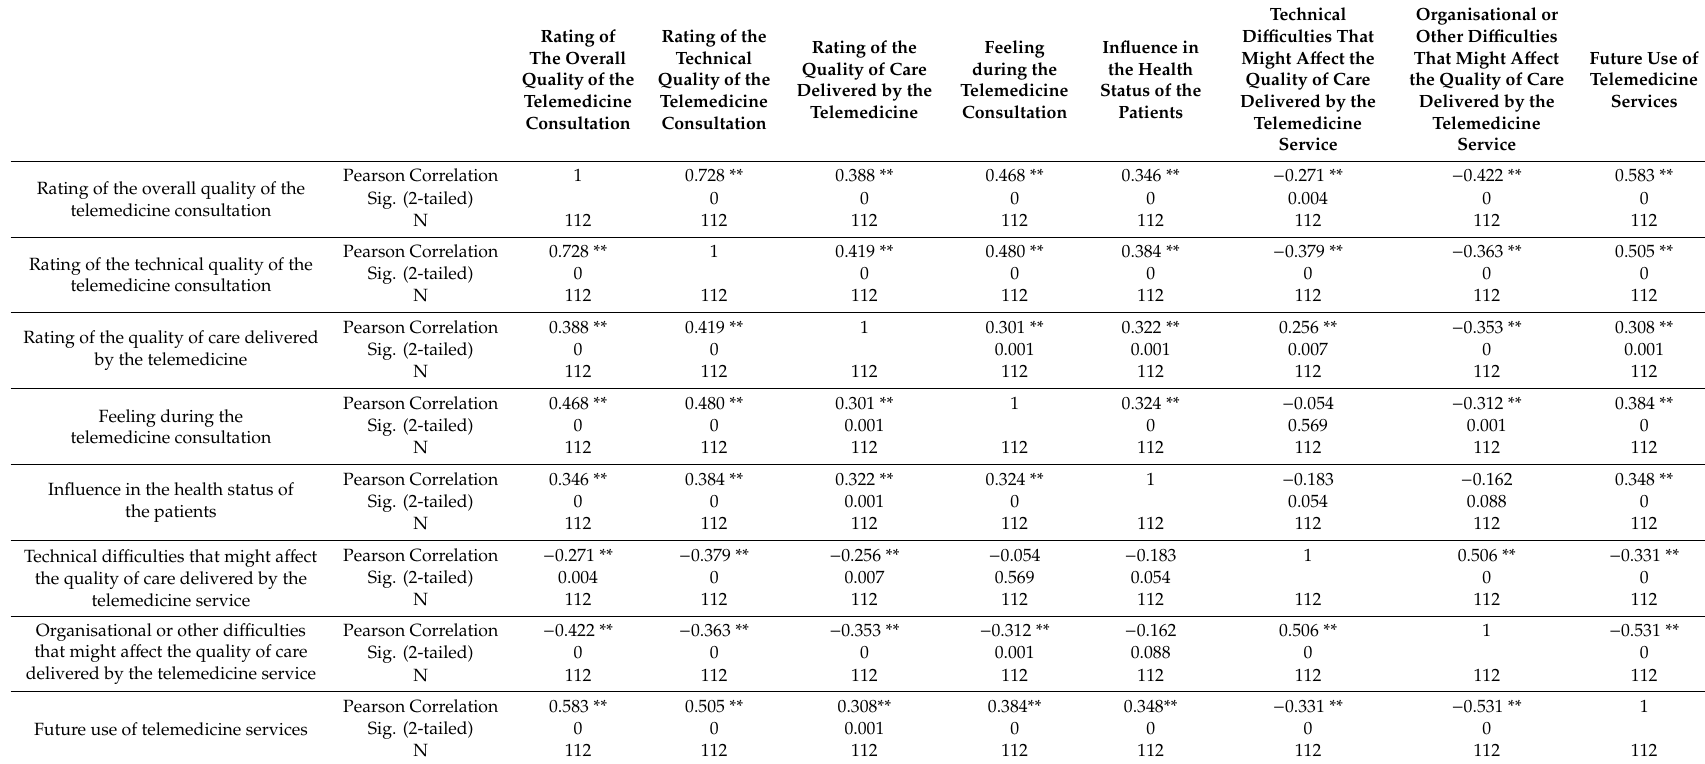
Table 4. Linear Correlations between